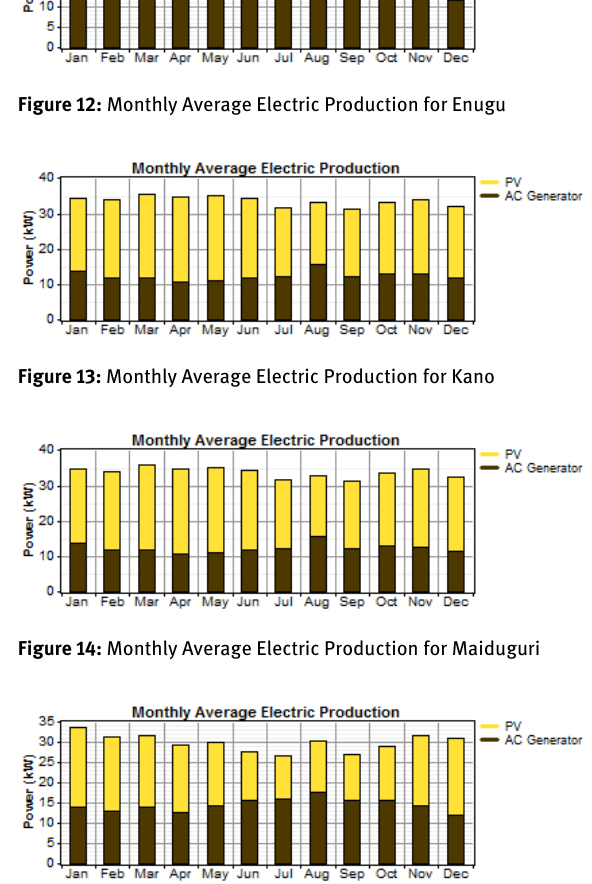
Figure 15: Monthly Average Electric Production for Warri